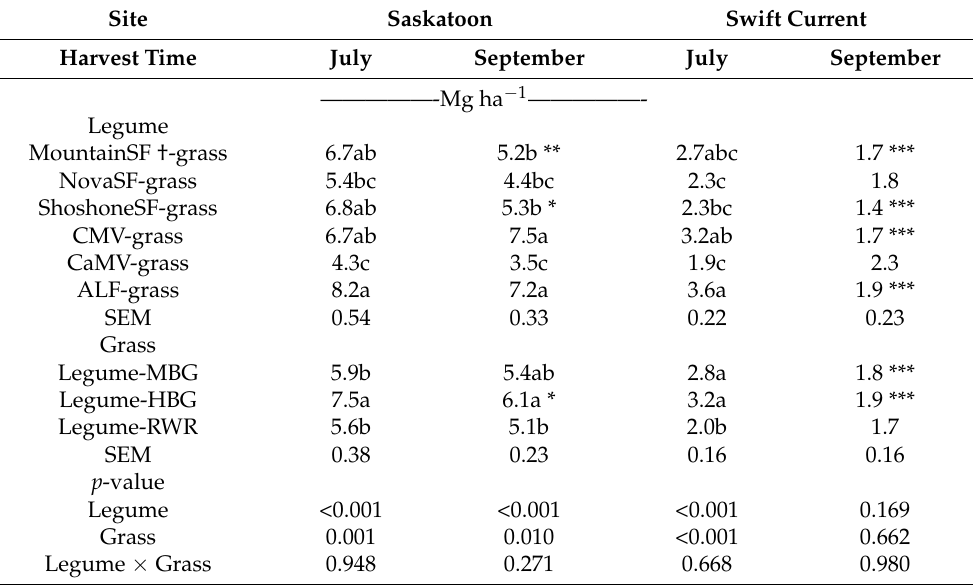
Table 2. Forage dry matter yield of legume-grass binary mixtures in July and September harvest at Saskatoon and Swift Current, Saskatchewan,